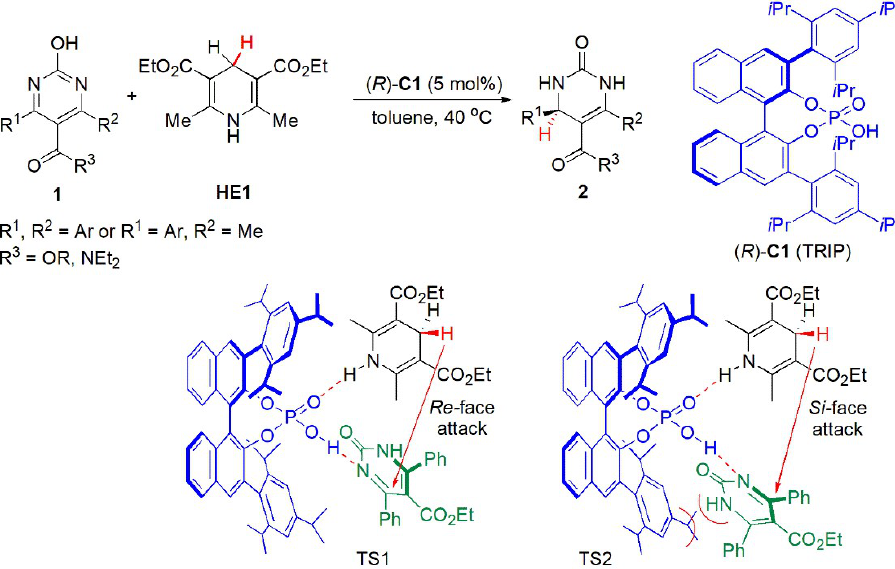
Figure 2. Enantioselective synthesis of 3,4-dihydropyrimidin-2(1 H )ones from 2-hydroxypyrimidines [38]. The synthesis of the alkyl-substituted DHPMs was subsequently achieved from pyrimidin-2-ones 3 , via 1,4-reduction with the same CPA and HE1 combination (Figure 3) [39]. Although N -methyl substituted substrates were used, there was no reduction of the C=N bond to yield a 1,2-reduced product, and the 1,4-reduced product was obtained exclu- sively. The reaction worked well with several alkyl substituents in the pyrimidin-2-one ring. The DHPMs 4 were obtained with very high yields and ees, with either electron-rich or electron-poor aryl substituents present in the aryl ring at C-4.